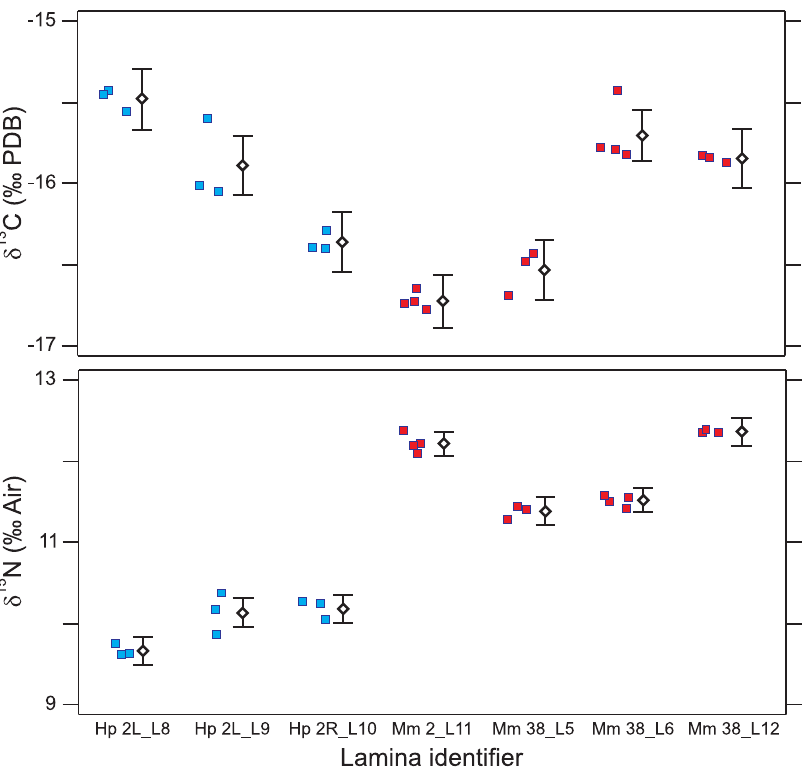
Figure 4. Intra- and inter-laminar comparison. Comparison of intra- and inter-laminar isotopic variation in white grunt specimen 2, left eye (Hp 2L) and right eye (Hp 2R) and gag specimens 2 and 38 (Mm 2 and Mm 38). Lamina number (e.g., L8 = lamina 8) is indicated within lamina identifiers. Data points have been horizontally jittered for clarity, and are summarized by means (diamonds) with 95% Tukey HSD intervals.